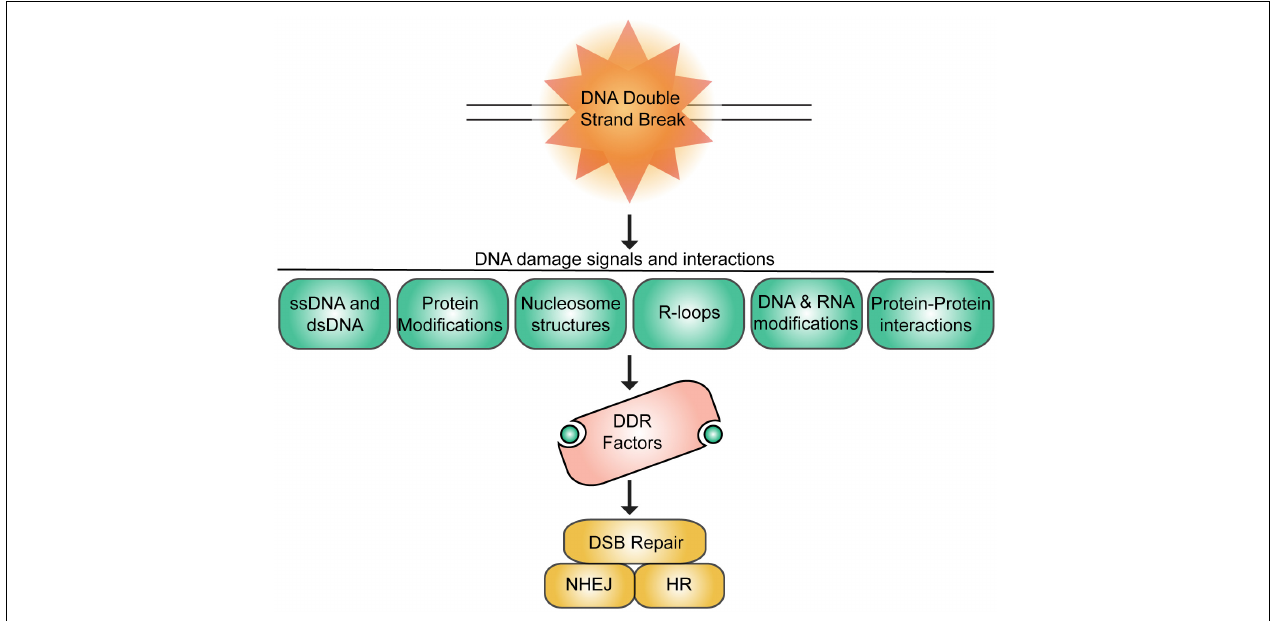
FIGURE 1 | Summary of DNA damage signals and interactions at DNA double-strand breaks. DSBs signal various chromatin associated signals that promote interactions and recruitment of DNA repair factors to breaks to engage DSB repair primarily by homologous recombination repair (HR) or non-homologous end-joining